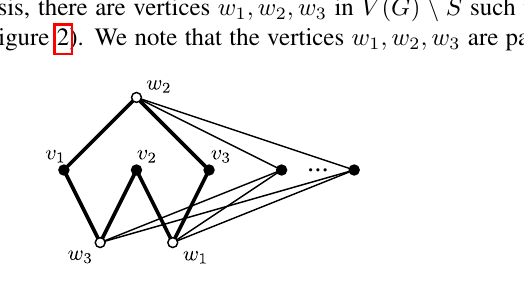
Fig. 2: The set S consists of black vertices. Vertices w 1 , w 2 , w 3 ∈ V ( G ) \ S such that w i ∼ S \ { v i } , i ∈ { 1 , 2 , 3 } . (otherwise, the graph G would contain K 3 as an induced subgraph). Since the graph G does not contain C 6 as an induced subgraph, there exists i ∈ { 1 , 2 , 3 } such that w i is adjacent to v i . Therefore w i ∼ S for some i ∈ { 1 , 2 , 3 } . It ends the proof of Theorem